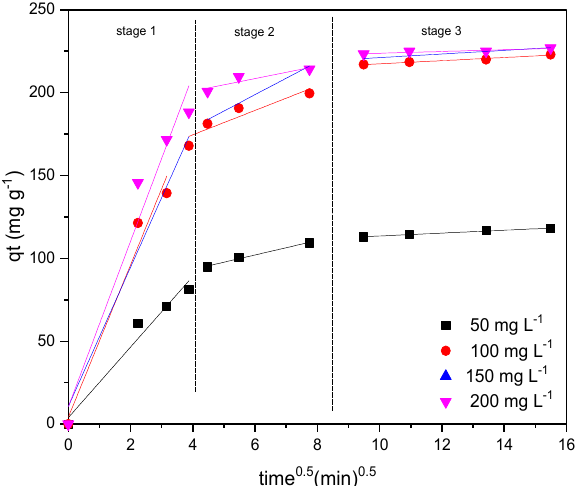
Figure 8. The intra-particle diffusion model linearly fitted to experimental data for adsorption of MB onto CXTi synthesised in this study, at initial concentrations of 50, 100, 150 and 200 mg L − 1 (T = 23 °C, dose = 0.01 g mL − 1 ).